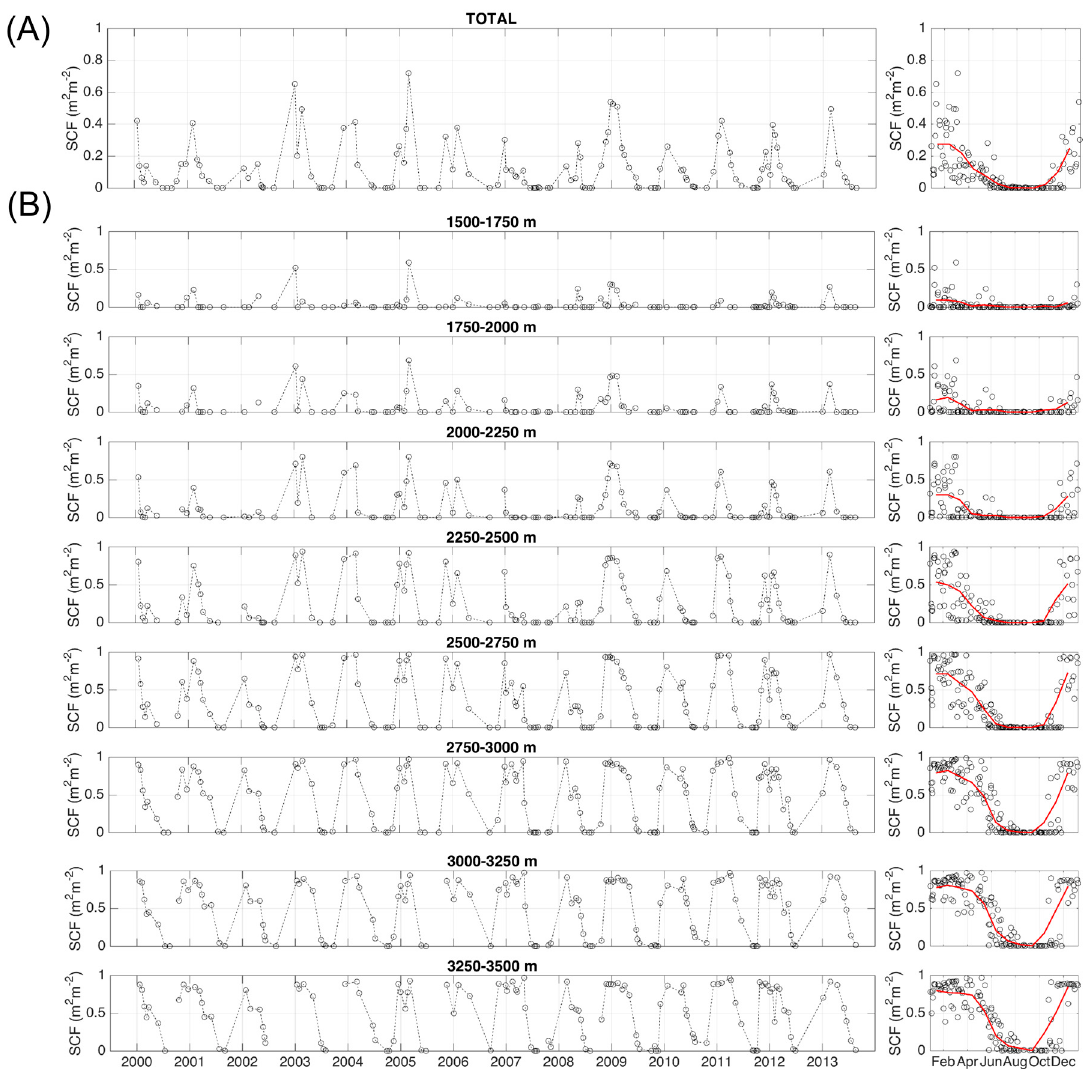
Figure 7. Left: Temporal evolution of the average SCF value at the Sierra Nevada range during the study period for the whole study area ( A ) and distributed within 250 m-range elevation bands ( B ). Right: Monthly distribution of the average SCF values (black dots) and monthly mean value (red line) for each case.